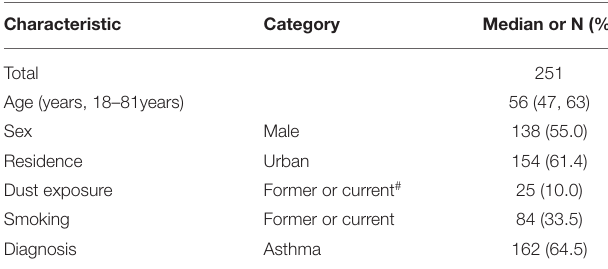
TABLE 1 | Demographic Characteristics of the included patients ( N = 251).